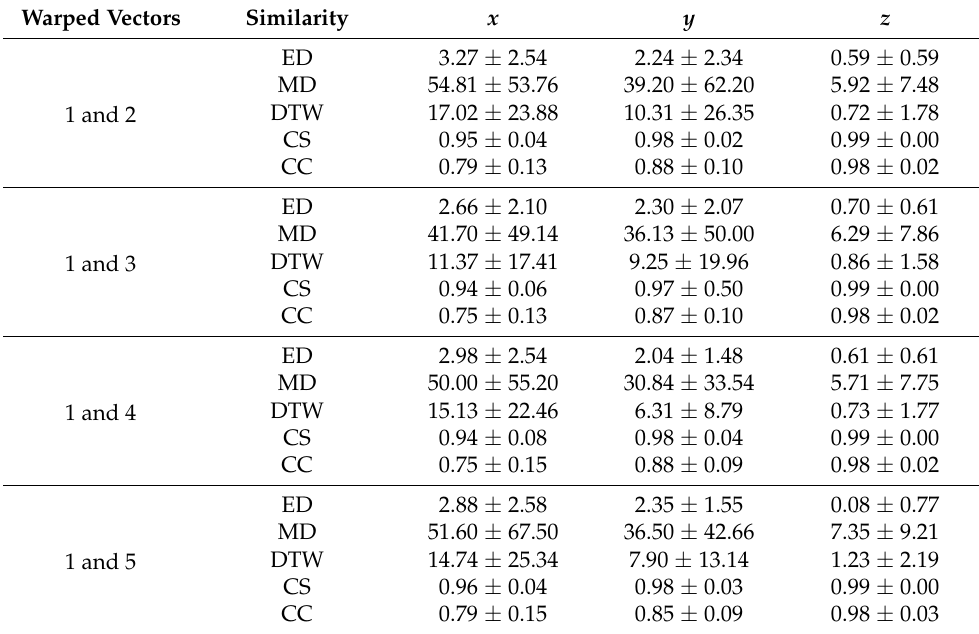
Table 1. Mean and standard deviation of the similarity verification results between time series.